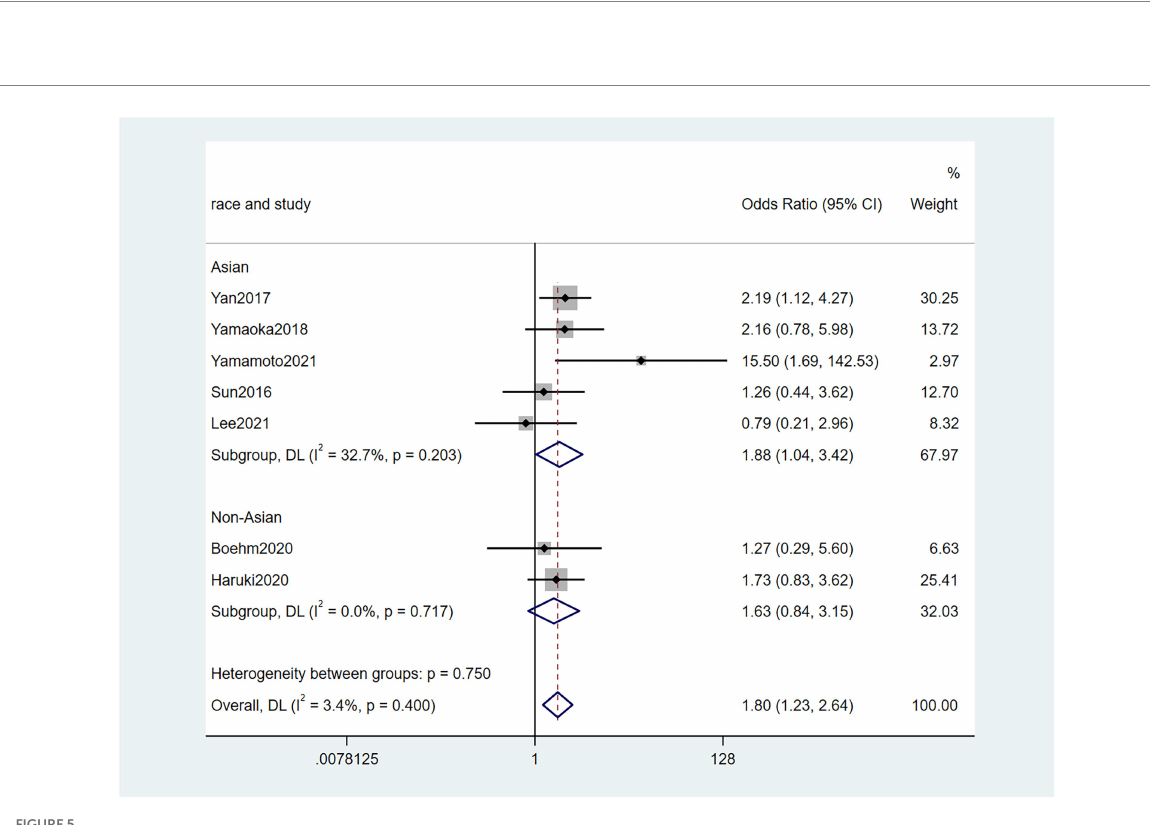
FIGURE 5 Forest plot of the relationship between Fusobacterium nucleatum and distant metastasis(pM) in